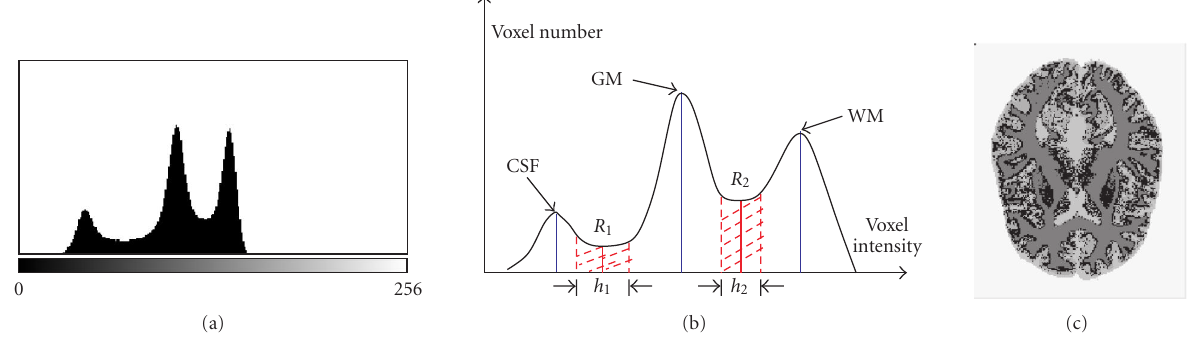
Figure 7: Active regions are determined by histogram analysis and thresholding of 3D MRI brain images. (a) The histogram of a sample 3D MRI brain image; (b) the center of R 1 is the trough between the CSF and GM peaks, the center of R 2 is the trough between the GM and WM peaks. h 1 and h 2 decide the size of R 1 and R 2 . (c) The brain image is separated into di ff erent regions by thresholding. The most black voxels represent the unlabeled pixels, and voxels with di ff erent gray values represent di ff erent initial CSF, GM, and WM